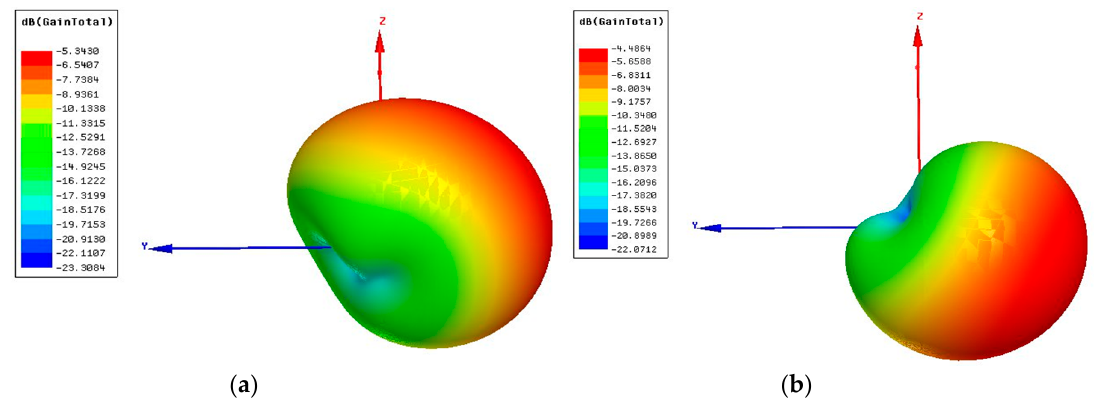
Figure 5. Total gain of the TX antenna (dBi) ( a ) at 2.5 GHz, ( b ) at 4.5 GHz.